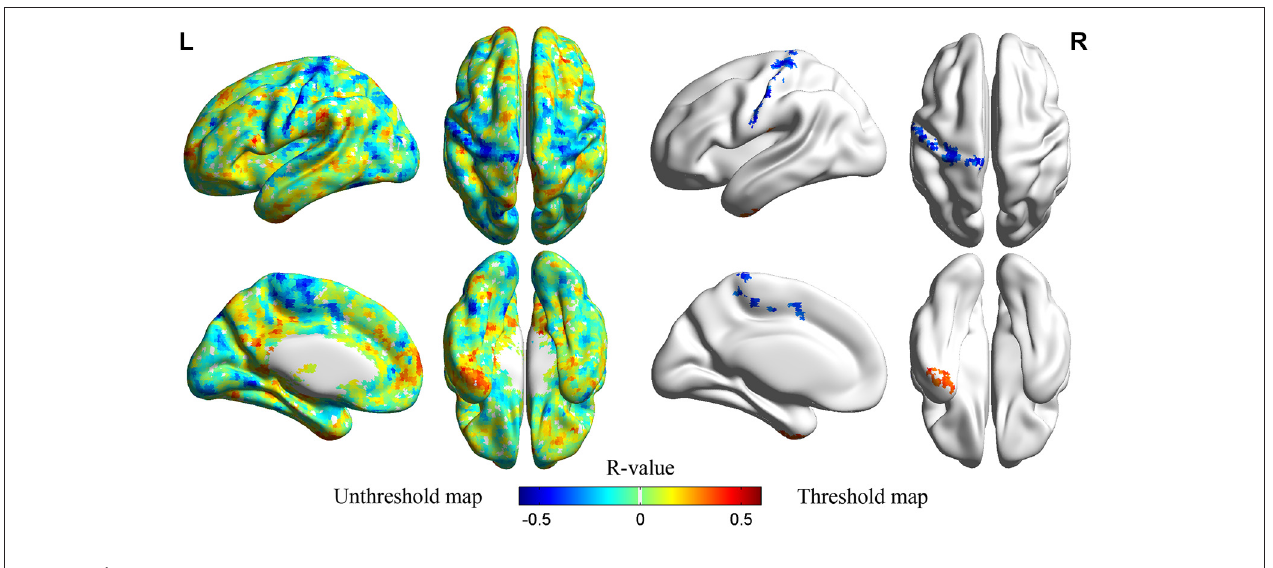
FIGURE 3 | Left unthreshold map showed correlations between averaged ALFF values and PLE without multiple comparison correction. The right threshold map displayed brain regions that